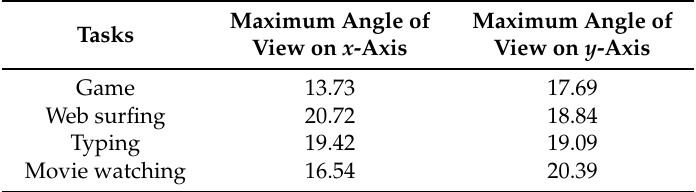
Table 3. The summarized results of Figures 7 and 8 (in °).